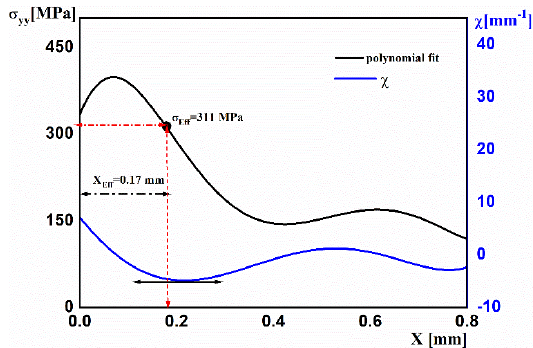
Figure 6. Schematic of polynomial fit and gradient of σ yy .